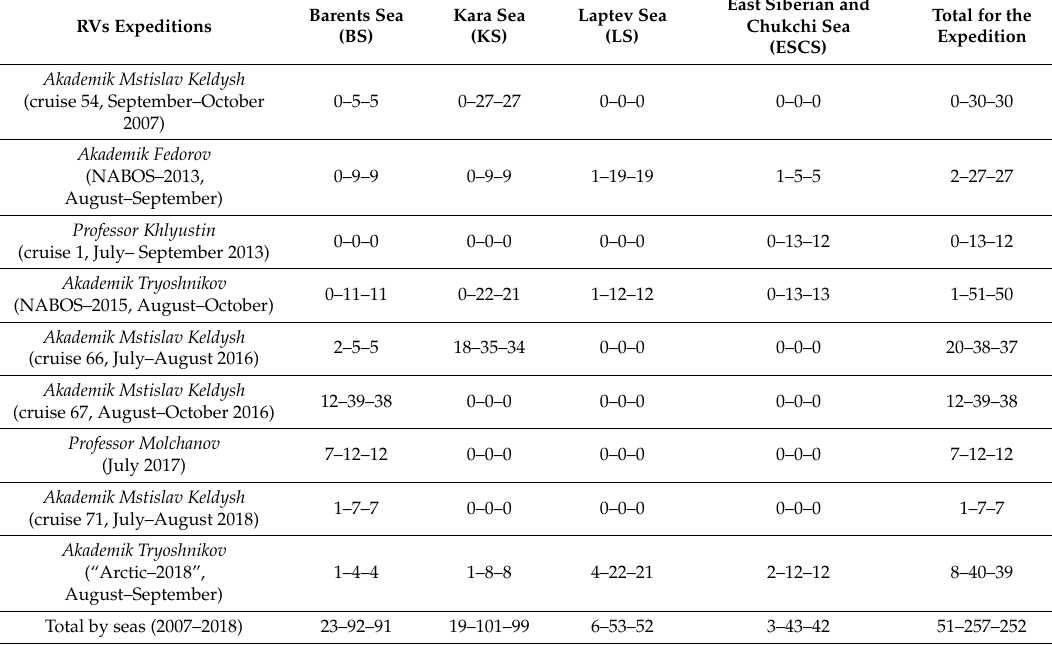
Table 2. Number of days of measurements aerosol characteristics ( τ a – N A – M BC ) in various Arctic seas and expeditions